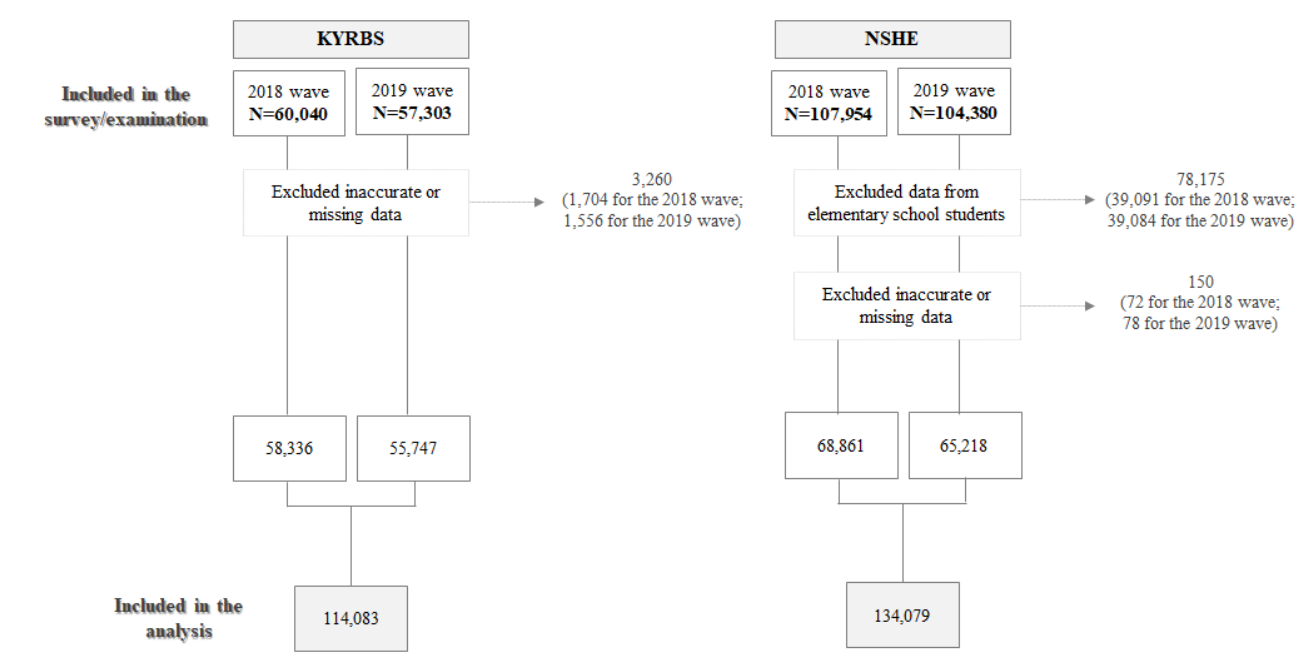
Figure 2. Participants included in the analysis. Table 1. Number and mean age of study participants of the KYRBS and NSHE (2018–2019).